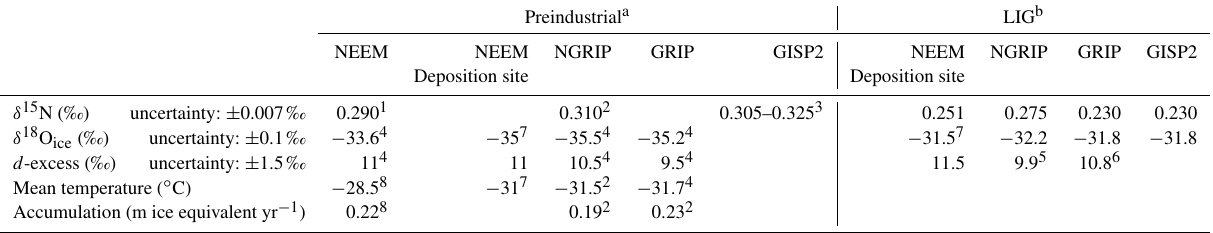
Table 1. Characteristics of Greenland deep ice core in the preindustrial period and during the LIG. The uncertainty corresponds to the standard error of the mean. Where data was compiled from previous studies, the references for the number in this table are taken from 1. Buizert et al. (2012); 2. Guillevic et al. (2013); 3. Kobashi et al. (2008), Bender et al. (2006); 4. Masson-Delmotte et al. (2005); 5. Capron et al. (2012); 6. Jouzel et al. (2007); 7. NEEM community members (2013); 8. Masson-Delmotte et al. (2015). Preindustrial